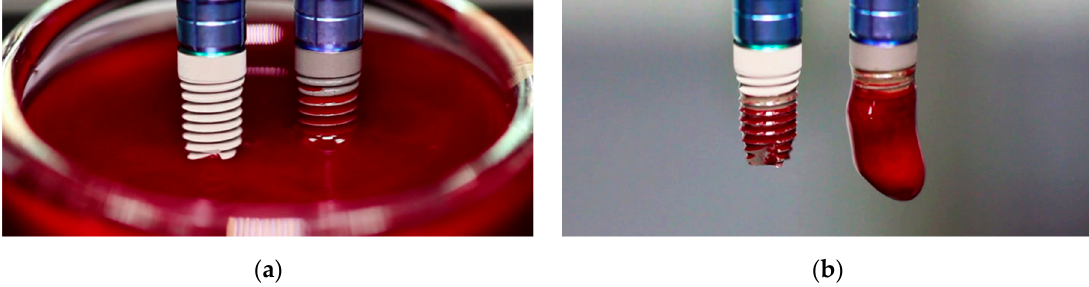
Figure 5. Implant immersion experiments in blood. ( a ) First contact of the implant surfaces with blood. ( b ) Resulting surfaces after 20 min incubation at room temperature in the blood-containing well.